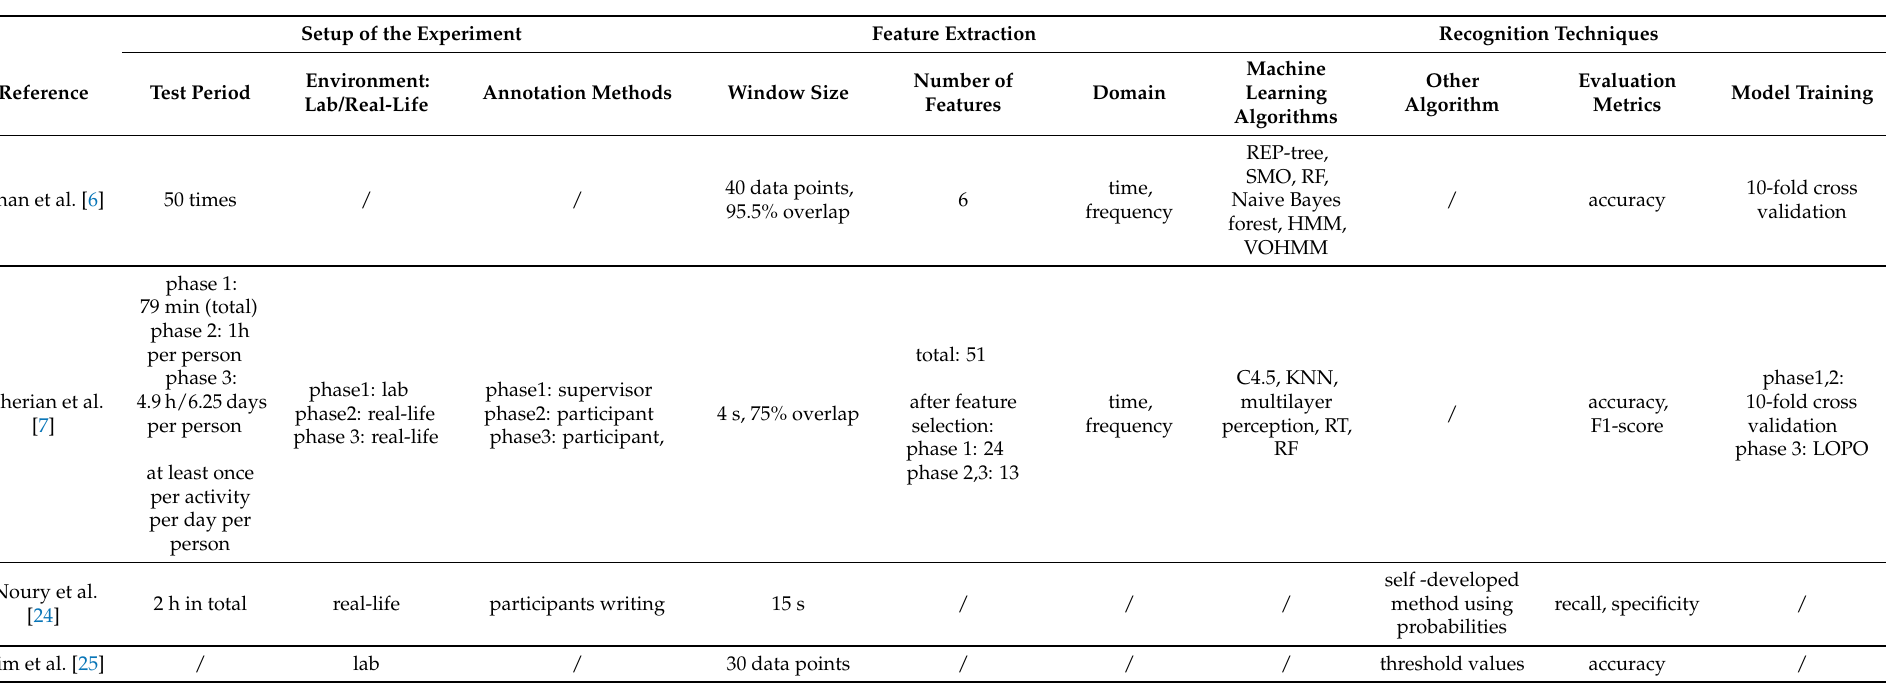
Table 3. Overview of extracted data from papers regarding target population, activities, sensor use, participants, setup of the experiment, feature extraction and recognition techniques ( con- tinued)